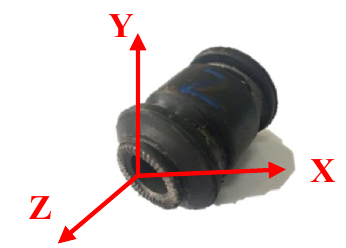
Figure 1. Rubber